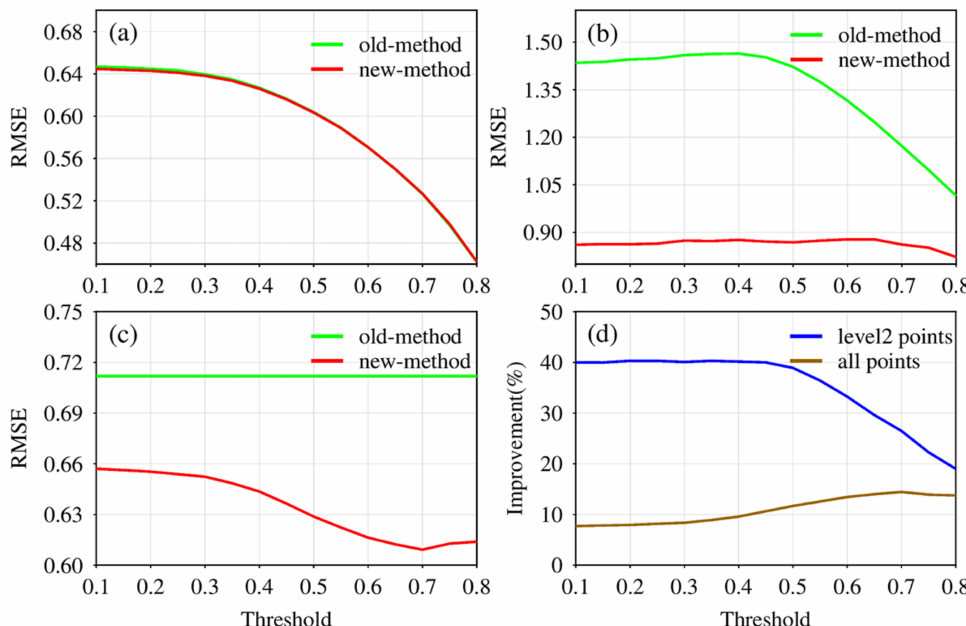
Figure 14. RMSE statistics under different hierarchical networking thresholds. ( a – c ) The RMSE changes in the first-level points, the second-level points, and all points with the increase in the hierarchical networking thresholds, respectively. ( d ) The accuracy improvement of the second-level points and all points with the increase in the hierarchical networking thresholds.